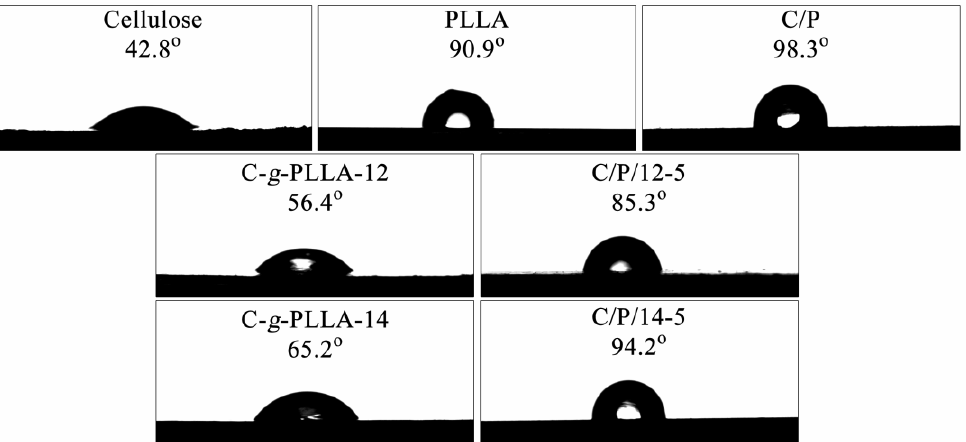
Figure 7. Static water contact angles of cellulose, PLLA, C/P, the compatibilizers, and the composites C/P/12-5 and